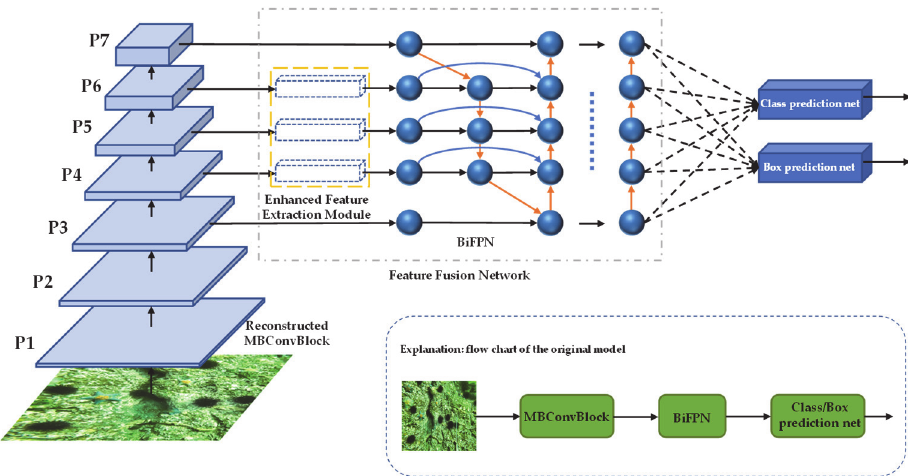
Figure 4. The structure of EDR. Where Reconstructed MBConvblock is the structure after adding Channel Shuffle to the original MBConvblock and replacing the fully connected layer with 1D convolution. Enhanced Feature Extraction network is a new structure, which is designed for multi- scale feature fusion before the original